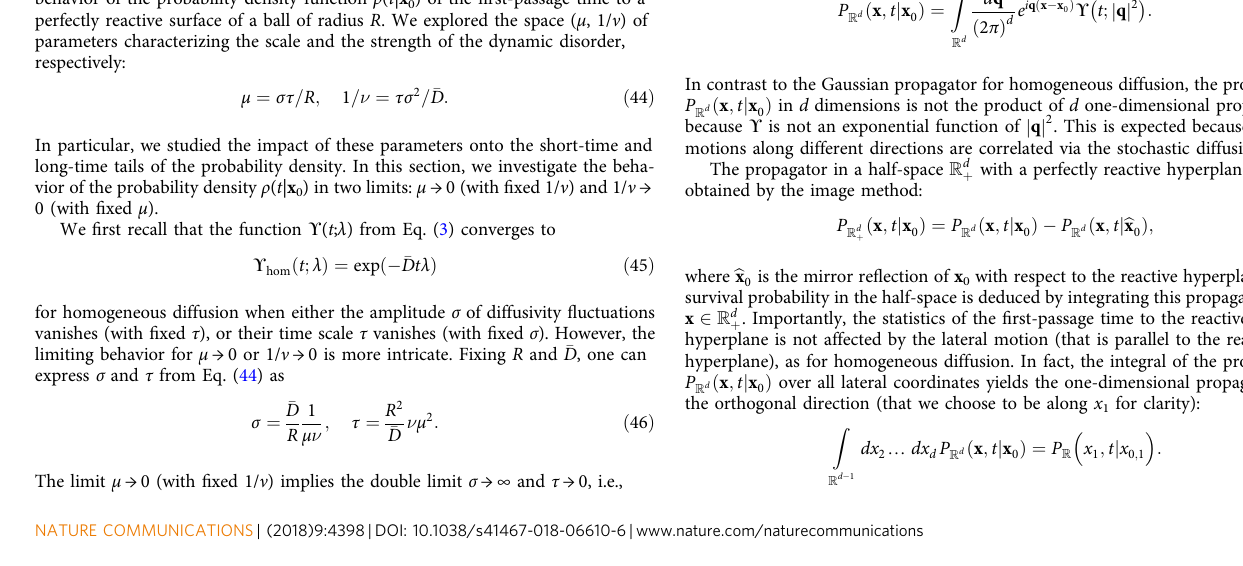
Fig. 4 The quality of the superstatistical approximation. Illustration for the probability density function of the fi rst-passage time from the center to the perfectly reactive boundary of a ball of radius R . The ratio between the exact solution ρ ( t |0) from Eq. (10) and its superstatistical approximation ρ t |0) from Eq. (43) is encoded by color and shown by 16 fi lled contours, 0 ( for ν = 2 ( a ) and ν = 0.5 ( b ). The approximation is accurate when the ratio (cid:9) (cid:10) is close to 1 (left upper corner). Here ν ¼ (cid:1) D = τσ 2 and μ = στ / μ = στ / R . When the disorder scale μ is large, the diffusivity D t does not change much from its randomly chosen starting value D 0 , so that the superstatistical approximation is accurate for a broad range of times (left upper corner of contour plots in Fig. 4). In this regime, deviations appear only at relatively long times (right upper corner). As the disorder scale μ decreases, the validity range of the superstatistical approximation progressively shrinks toward very short times. This is true for both weak (1/ ν = 0.5) and strong (1/ ν = 2) disorder, deviations being higher in the latter case. We conclude that the superstatistical approximation and the resulting short-time behavior are accurate when μ is not too small. Limiting behavior of the probability density function . Figure 2 illustrated the behavior of the probability density function ρ ( t | x 0 ) of the fi rst-passage time to a